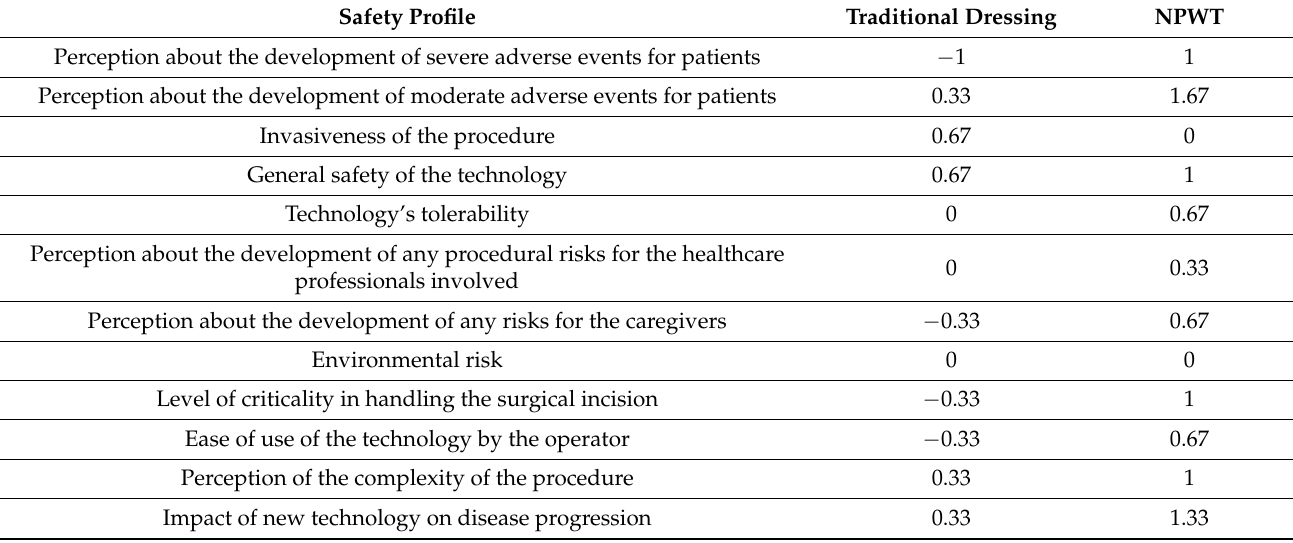
Table 4. Healthcare professionals’